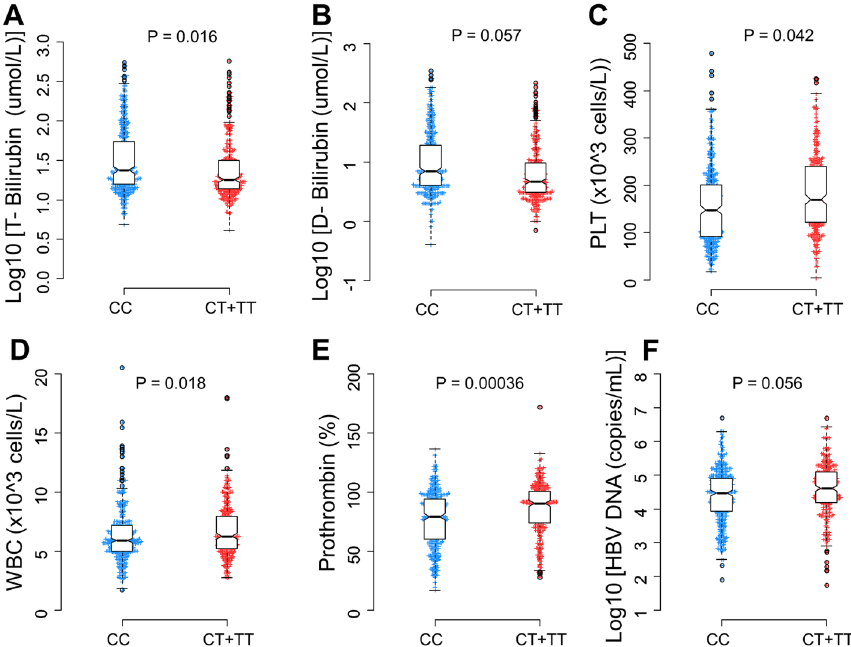
Figure 2. Association of PD-1.5 variant with distinct laboratory parameters in HBV patients. Box-plots illustrate median values with 25 and 75 percentiles with whiskers to 10 and 90 percentiles; p- values were calculated by Mann–Whitney test.